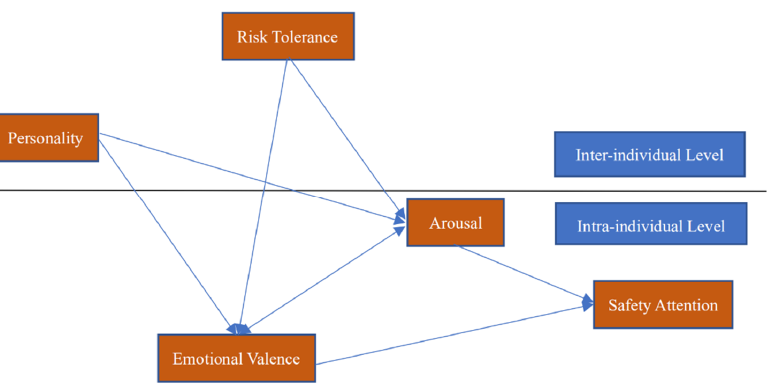
Figure 3. Best-fit SEM (Structural equation modeling).